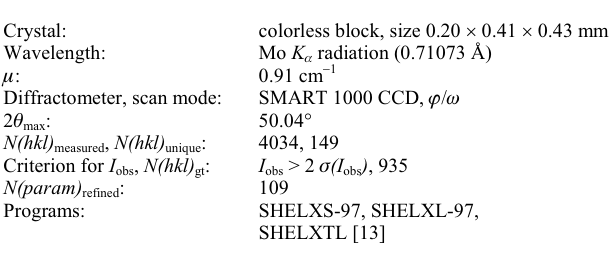
Table 1. Data collection and handling.